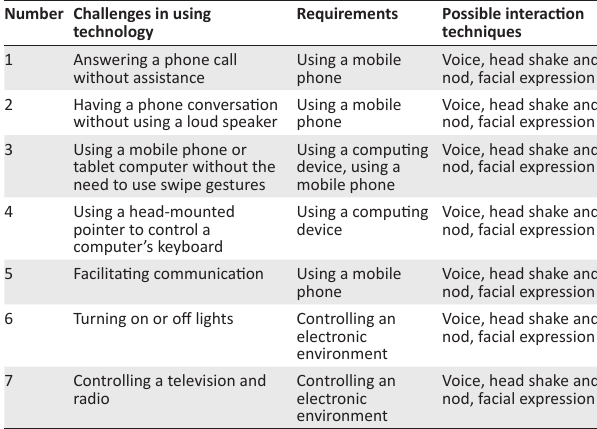
TABLE 4: Software design